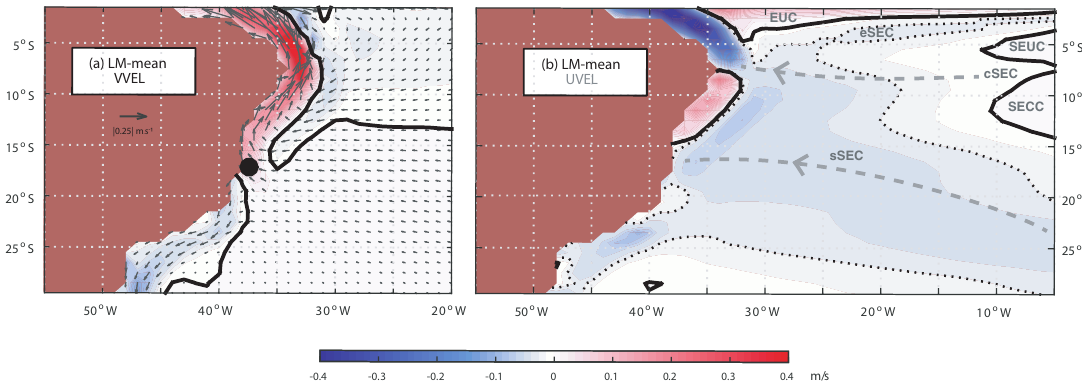
Figure 2. LM-mean South Atlantic Ocean (SAO) circulation pattern. Depth-integrated flow over the upper 200 m for the LM (850–1849): ( a ) Zonal and meridional velocities (UVEL, VVEL, respectively, as vectors) superposed on the meridional velocities (background colors). Red (blue) denotes positive, northward (negative, southward) velocities. Black contours mark the zero meridional velocity line, and the black dot represents the mean sSEC bifurcation latitude (SBL) at 25 m. ( b ) Zonal velocities (background colors). Red (blue) denotes positive, eastward (negative, westward) velocities. Black filled contours mark the zero zonal velocity line, and black dotted contours mark the − 0.02 m/s contour, for reference. Mean zonal currents from south to north are: the southern branch of the South Equatorial Current (sSEC), the South Equatorial Countercurrent (SECC), the central branch of the South Equatorial Current (cSEC), the South Equatorial Undercurrent (SEUC), the equatorial branch of the South Equatorial Current (eSEC), and the Equatorial Undercurrent (EUC). Gray dashed lines indicate the sSEC and cSEC direction, for